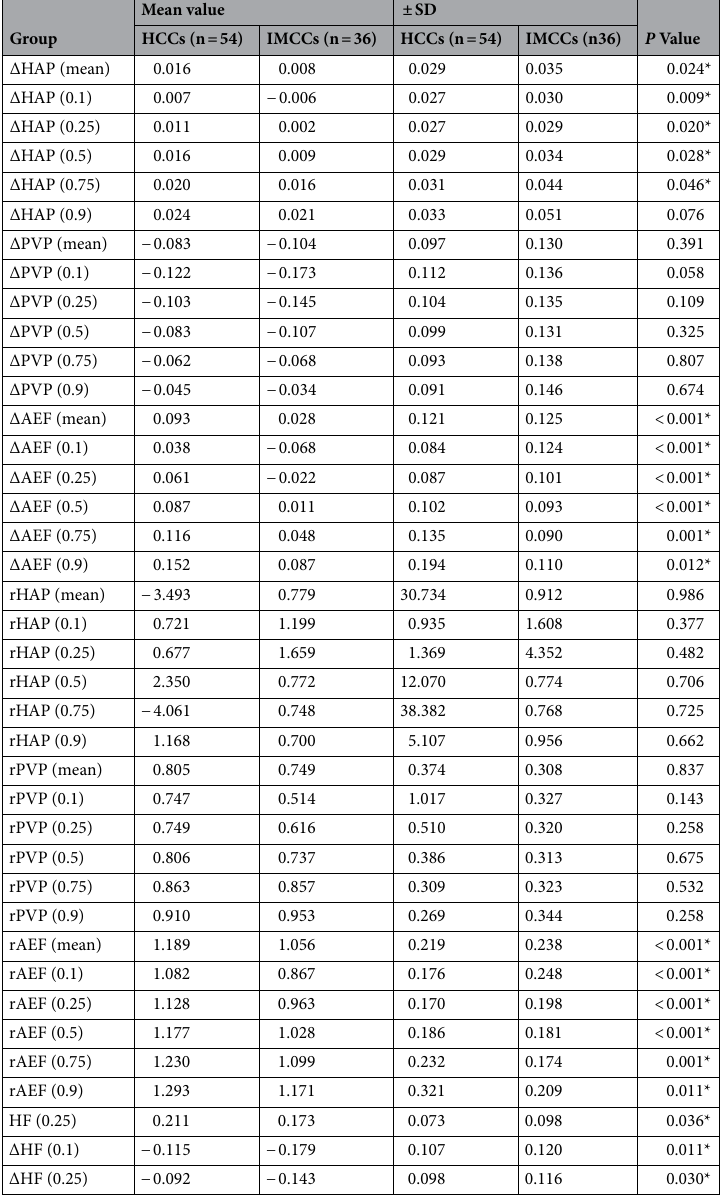
(P < 0.05). ∆HAP Difference in hepatic arterial perfusion (HAP tumor −HAP liver ), ∆HF Difference in blow between tumor and liver (HF tumor −HF liver ), ∆PVP Difference in portal vein perfusion (PVP tumor −PVP liver ), ∆AEF Difference in the arterial enhancement fraction (AEF tumor −AEF liver ), rHAP Relative hepatic arterial perfusion (∆HAP/HAP liver ), rHF Relative total tumor flow (∆HF/HF liver ), rPVP Relative portal vein perfusion (∆PVP/